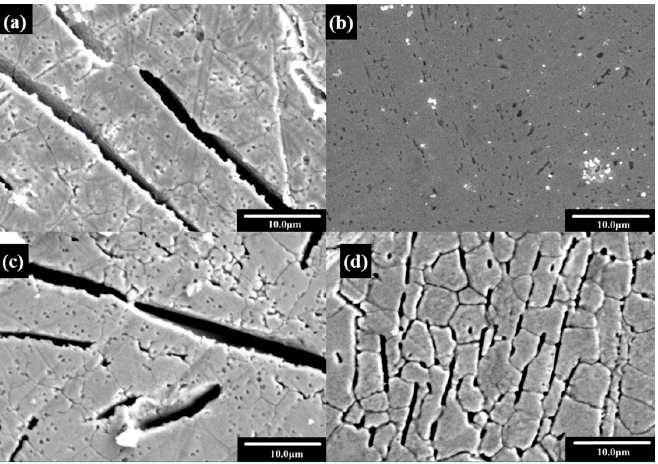
Figure 5. SEM images of Sn–8Zn–3Bi solder alloy after immersed in 3.5% NaCl solution for 5 h (( a ): SC alloy; ( b ): RC alloy) and 12 h (( c ): SC alloy; ( d ): RC alloy).